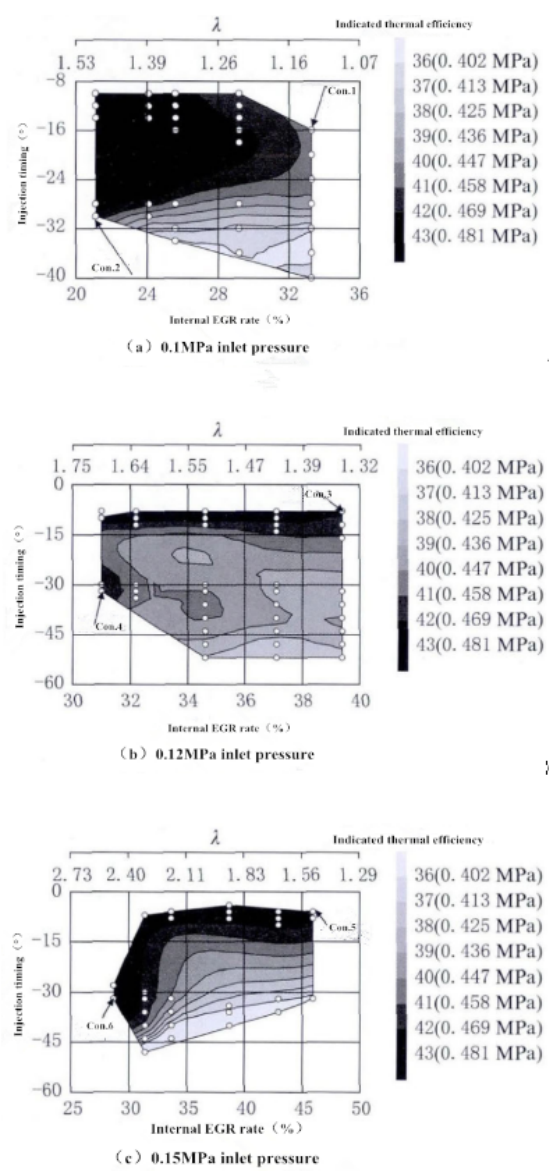
Fig. 9 Effect of fuel injection timing, internal EGR rate and excess air coefficient λ on indicated thermal efficiency and average indicated pressure under different intake pressures